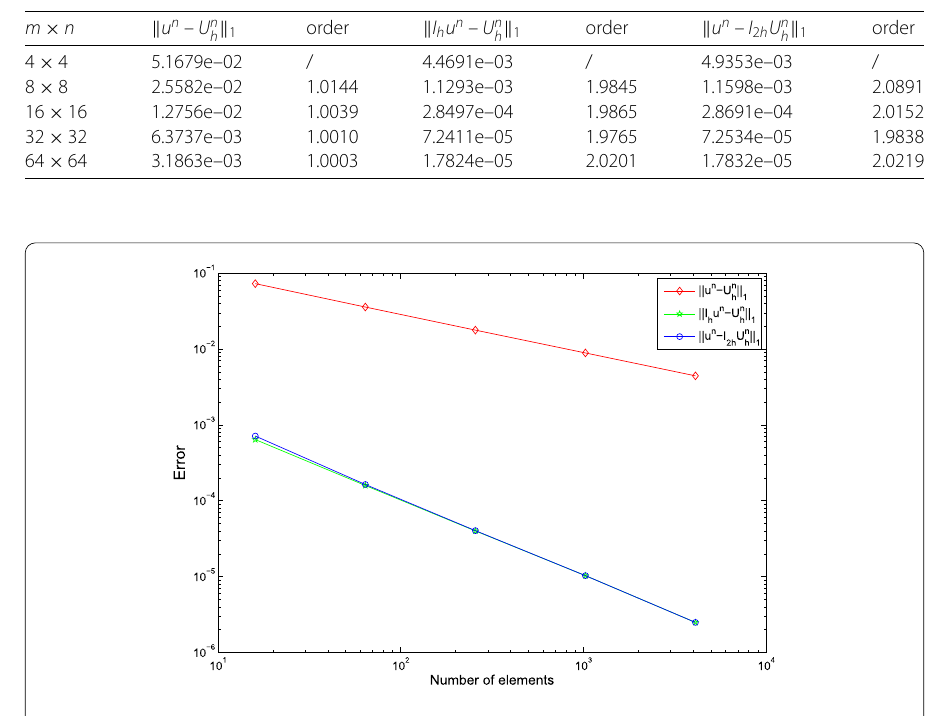
Figure 4 Numerical results for u at t =